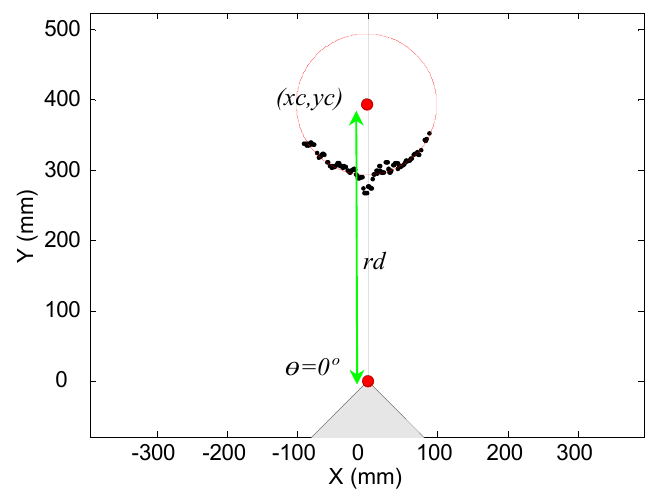
Figure 8. Example of circular target location.